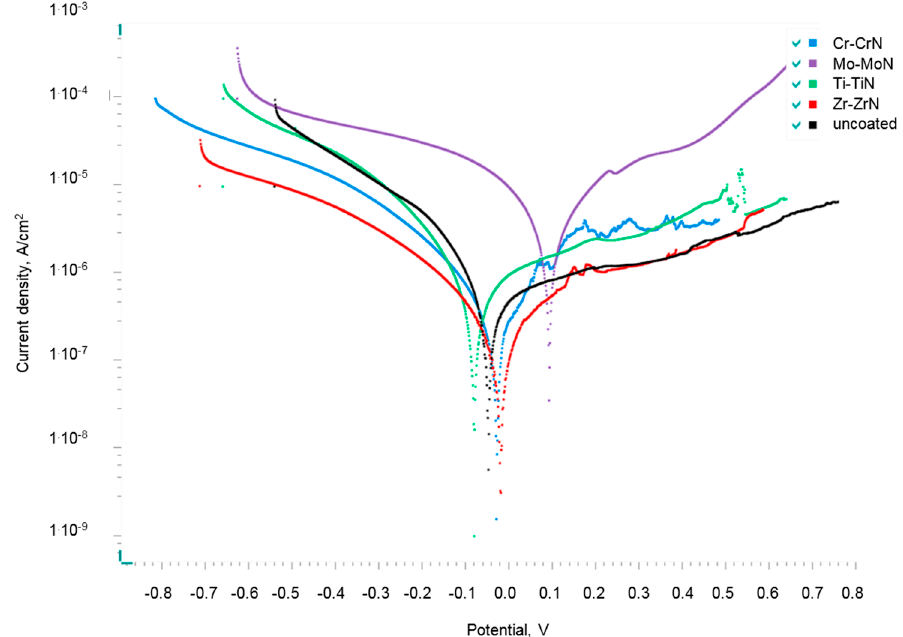
Figure 6. Alignment of potentiodynamic curves of the considered coatings of Cr-CrN, Ti-TiN, Zr-ZrN, and Mo-MoN on the substrate of Ti-6Al-4V alloy which were obtained in the 3 wt.% aqueous solution of NaCl (the potential sweep rate V p = 1 mV/s).